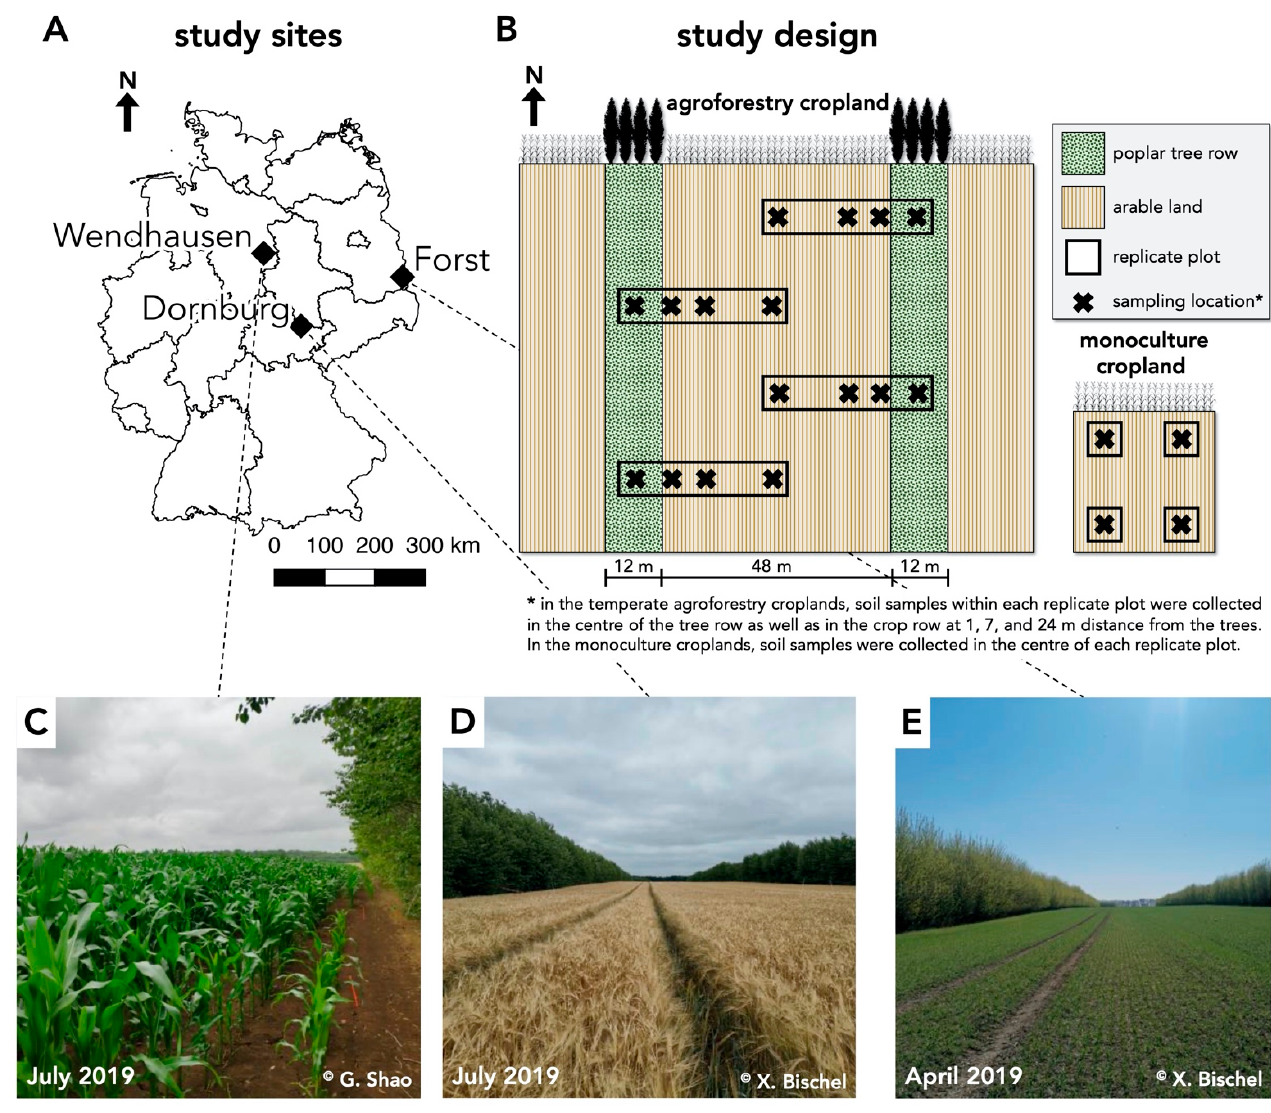
Figure 1. Study sites and study design of paired temperate agroforestry and monoculture croplands. ( A , C – E ) Study sites on a Calcaric Phaeozem (near Dornburg, Thuringia), Gleyic Cambisol (near Forst, Brandenburg), and Vertic Cambisol soil (near Wendhausen, Lower Saxony) in Germany. Black lines on the map represent borders of federal states. ( B ) Soil samples within each replicate plot of the temperate agroforestry croplands were collected in the centre of the tree row as well as in the crop row at 1, 7, and 24 m distance from the trees in order to cover the spatial heterogeneity of the systems. In the monoculture croplands, soil samples were collected in the centre of each replicate plot.